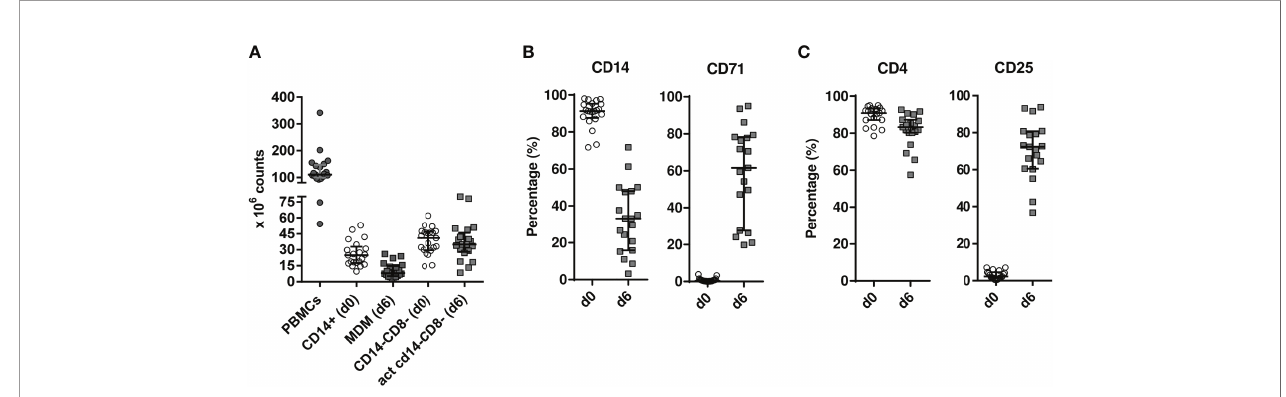
FIGURE 2 | Cellularity (A) and fl ow cytometry analysis (B, C) of cultured cell subsets. (A) CD14 + monocytes and CD14 − CD8 − cells were magnetically isolated from PBMCs in 100 ml EDTA-treated patient blood at HIV isolation onset [day 0 (d0)]. Individual cellularity is depicted as solid circles for whole PBMC, while empty circles and solid squares are graphed for cell fractions at days 0 (d0) and 6 (d6), respectively, with median values shown as horizontal solid lines. (B) CD14 + monocyte differentiation to monocyte-derived macrophages (MDMs) was tracked by CD14 and CD71 analysis. To that goal, cells were FSC/SSC gated and analysed the monocytic window ( Supplementary Figure S1A ) (C) . On the other hand, 24-h-activated CD14 − CD8 − cells later cultured for fi ve more days in IL-2-containing medium were plotted at d0 and d6 for CD4 and CD25 expression in FSC/SSC-gated cells restricted to a CD3 + lymphocytic window ( Supplementary Figure S1B ). PBMC, peripheral blood mononuclear cell; act, activated; FSC, forward scatter; SSC, side